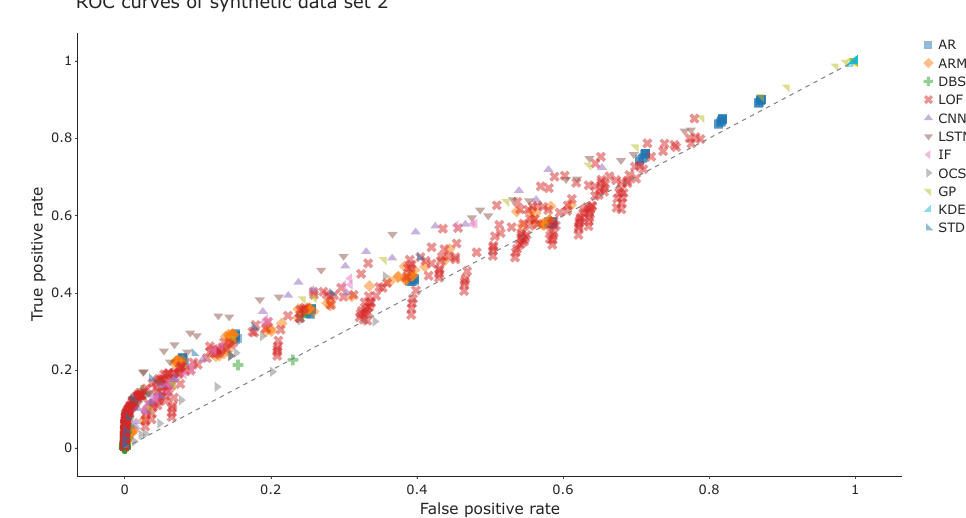
Figure 11. Results of the anomaly detection models based on synthetic data set